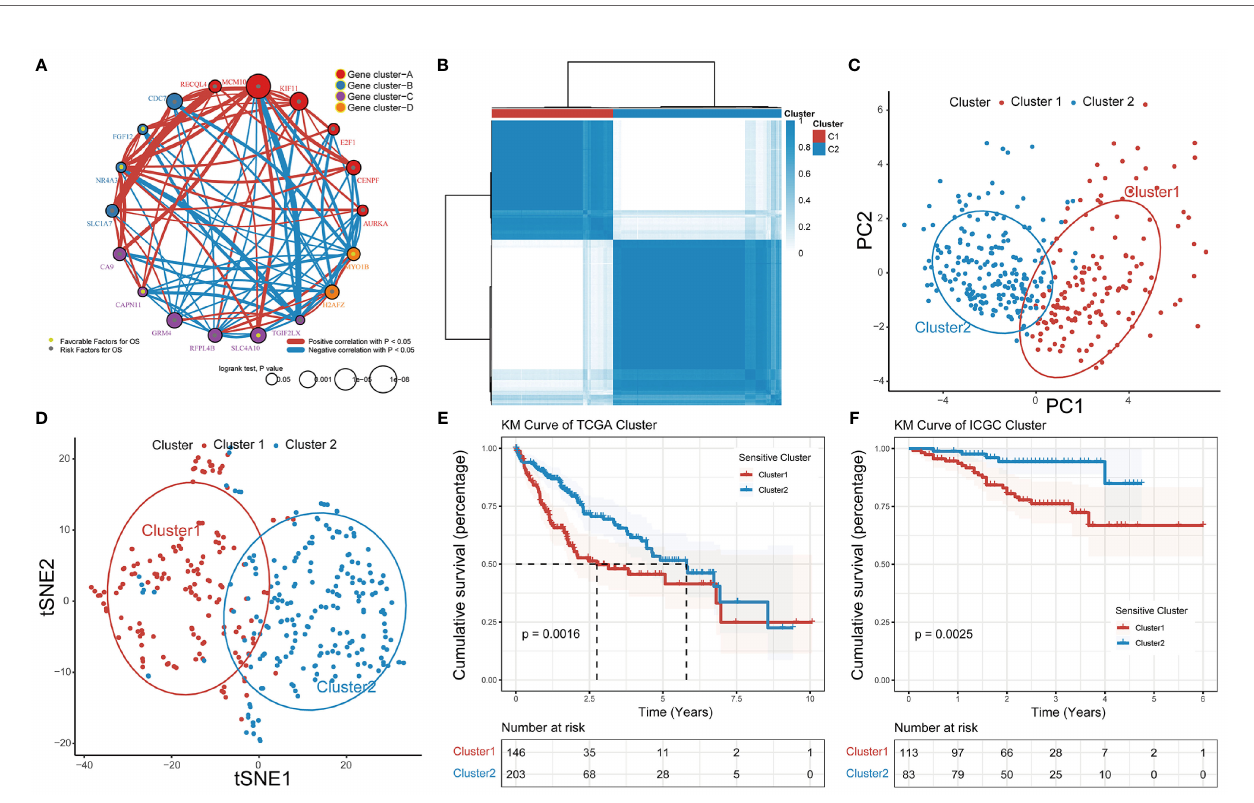
FIGURE 2 | Patterns of TTK and their prognostic value in HCC. (A) Interactions among 18 GSTTKs in HCC. The circle size represents the effect of each regulator on prognosis, and comparisons were made using the log-rank test ( p < 0.05, p < 0.001, p < 1E-05 and p < 1E-08). Green dots in the circle represent risk factors for prognosis; gray dots represent favorable factors for prognosis. The lines linking the regulators show interactions, and the line thickness indicates the strength of the correlation. Positive correlations are marked in red and negative correlations are shown in blue. The regulator clusters A – D are marked in red, blue, purple, and orange, respectively. (B) Two patterns of TTK were identi fi ed by unsupervised clustering. Cluster1, red; Cluster2, blue. (C, D) PCA and tSNE veri fi ed the two patterns in HCC. Two subgroups without intersection were identi fi ed, indicating that Cluster1 and Cluster2 samples could be clearly distinguished based on GSTTK expression pro fi les. (E, F) Survival analysis indicated that patients assigned to the two clusters had signi fi cantly different survival outcomes in TCGA-LIHC and ICGC- LIRI-JP